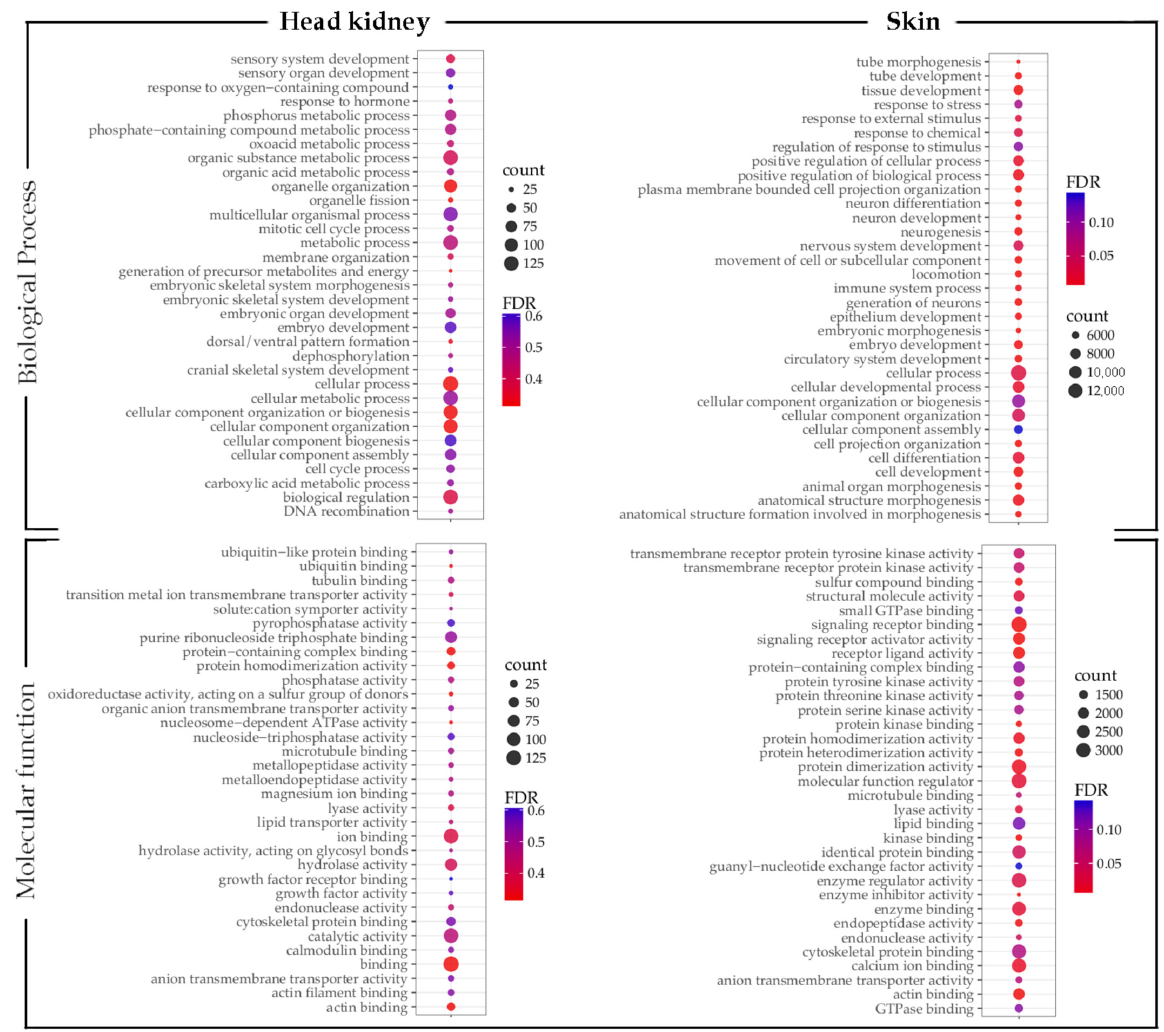
Figure 6. GO enrichment analysis of shared expressed transcripts in vaccinated fish groups. The size of the circles indicates the number of transcripts that enriched the GO term. Colors indicate the p -value.